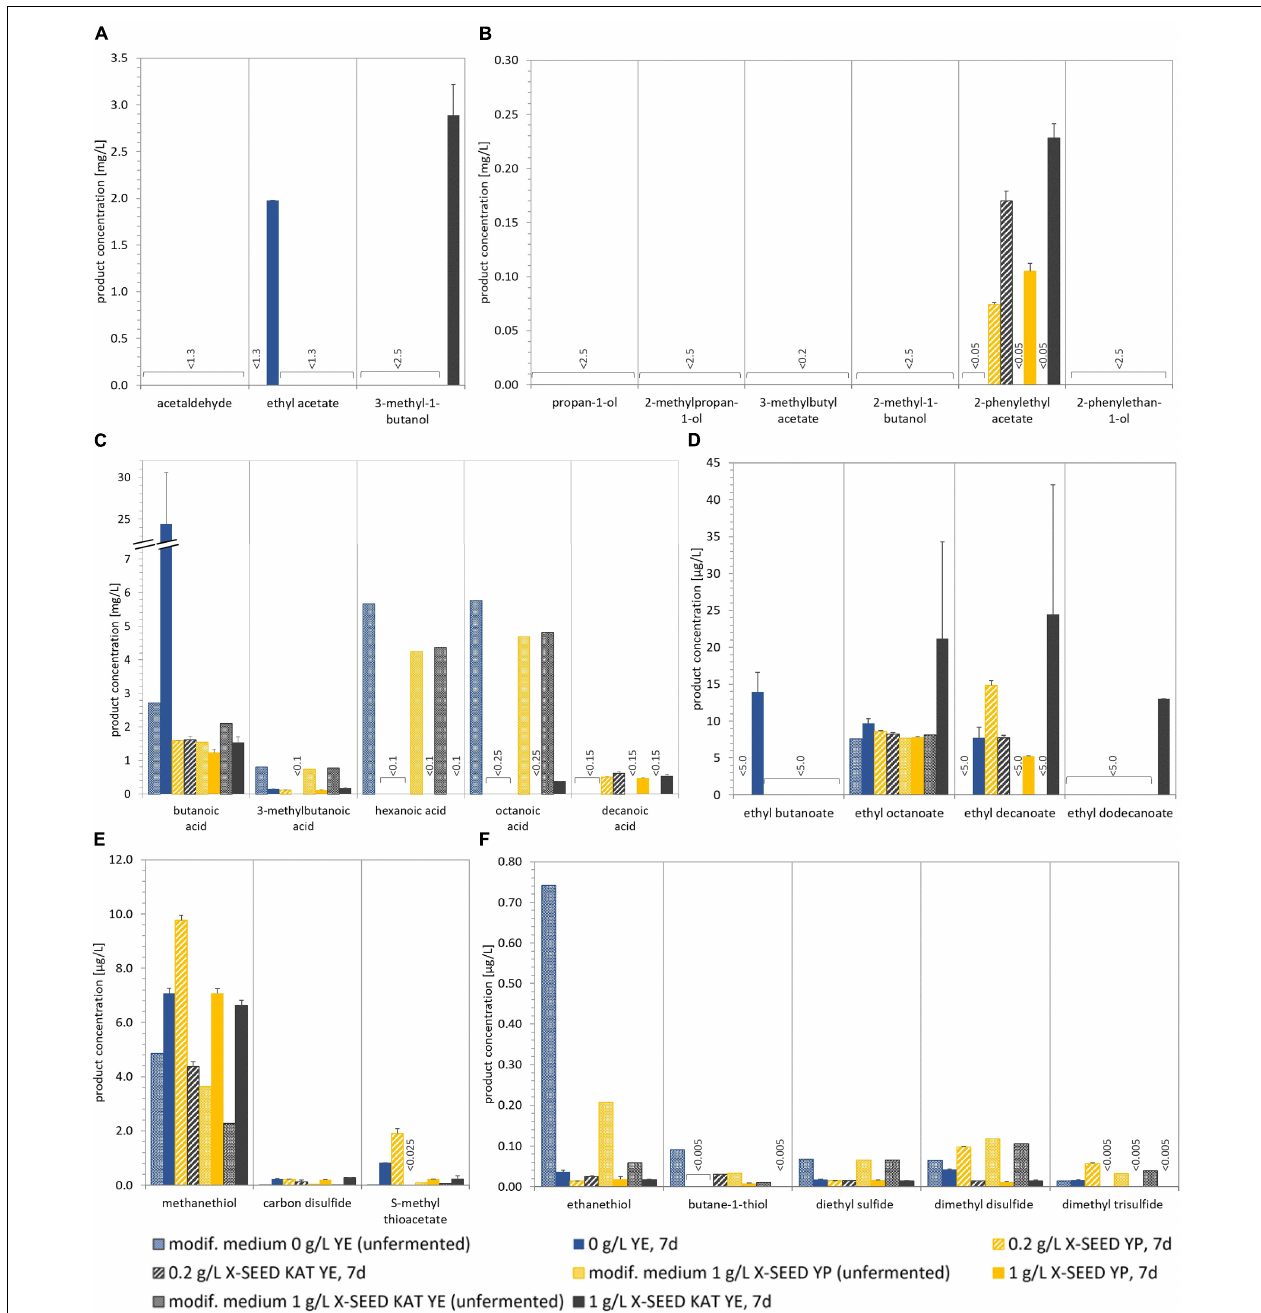
FIGURE 6 | Concentrations of different volatile components in modified media (references) and in 7-day fermented beverages produced with the Leu + Han combination and different types and amounts of YE. The quantified aroma-relevant analytes included higher aliphatic alcohols and esters (A,B) , fatty acids (C) , fatty acid ethyl esters (D) , and thiols and other sulfur components (E,F) . The detection limit is specified for the components for which no detection was possible. The analytes pentanoic acid, dodecanoic acid, ethyl hexanoate, and propane-1-thiol (all not shown) were not detected in any sample. Data are the mean value of biological duplicates ± mean deviation. YE, yeast